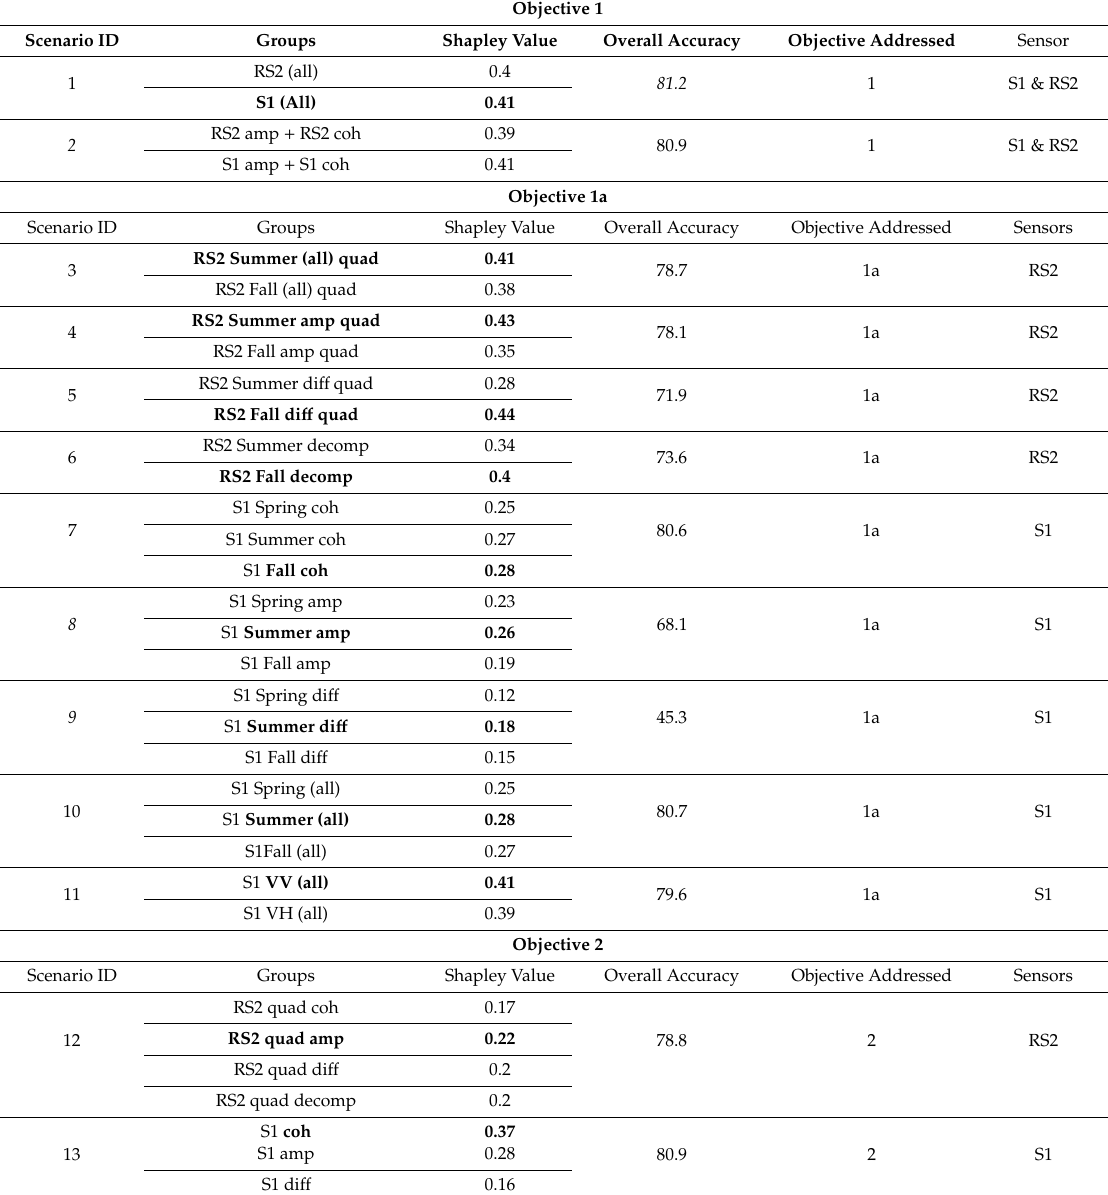
Table 2. Results of scenarios that compare di ff erent sensors, data types, seasons, and so on, listed by objective addressed and sensors used in assessment. Bold font in Shapley value column indicates the most important group of variables in that comparison. Italicized font in overall accuracy column indicates the classification scenario with the highest overall